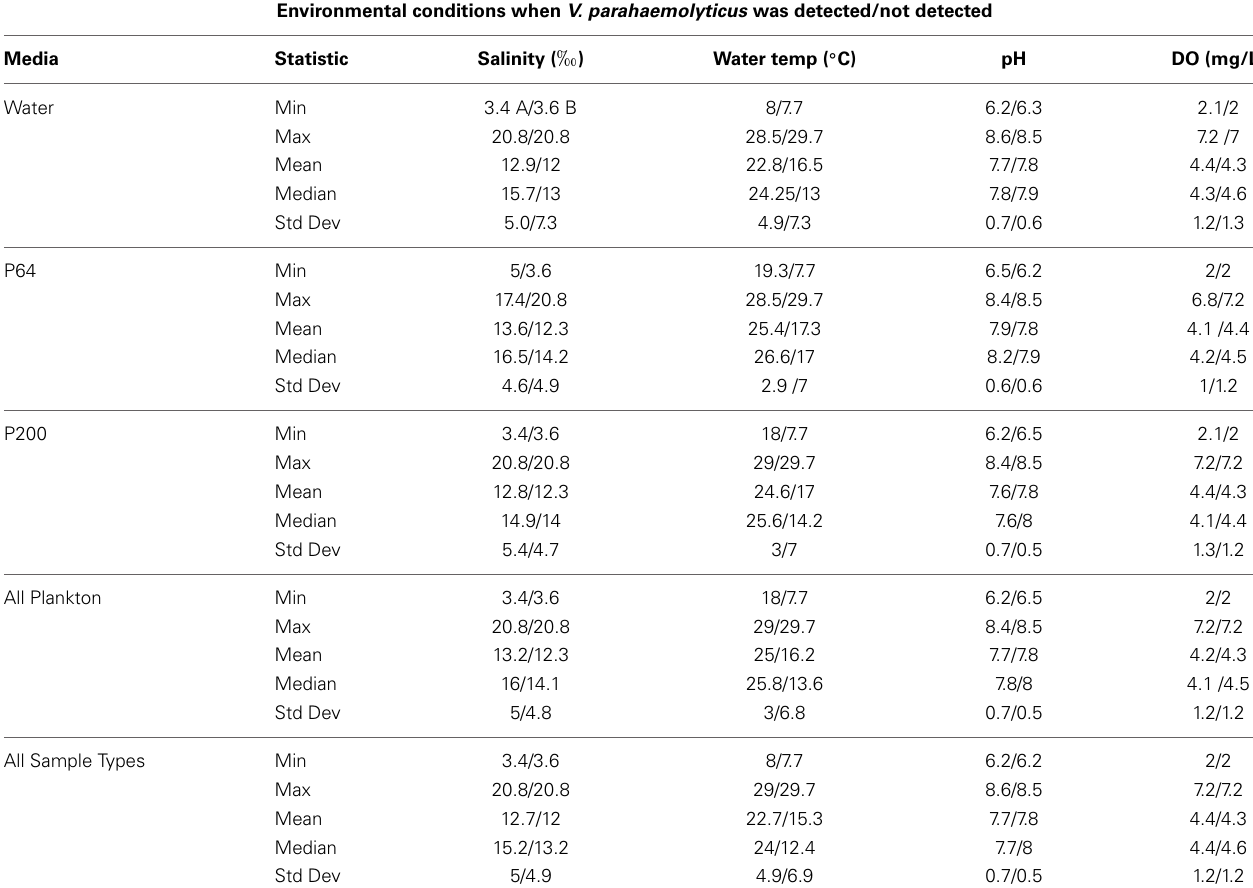
Table 1 | Recorded environmental parameters when V. parahaemolyticus was/was not detected for each sample type. Environmental conditions when V. parahaemolyticus was detected/not